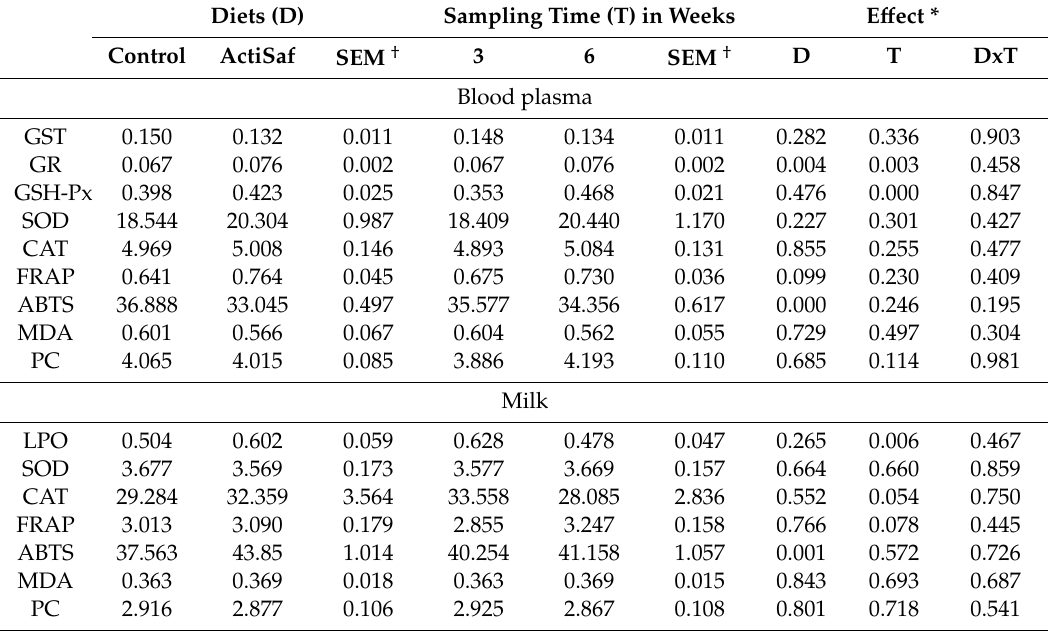
Table 3. Enzymes activities (Units / mL), total antioxidant capacity, and oxidative status biomarkers in blood plasma and milk of ewes fed the two diets (Control, n = 8 and ActiSaf, n = 8) at two sampling times. Diets (D) Sampling Time (T) in Weeks